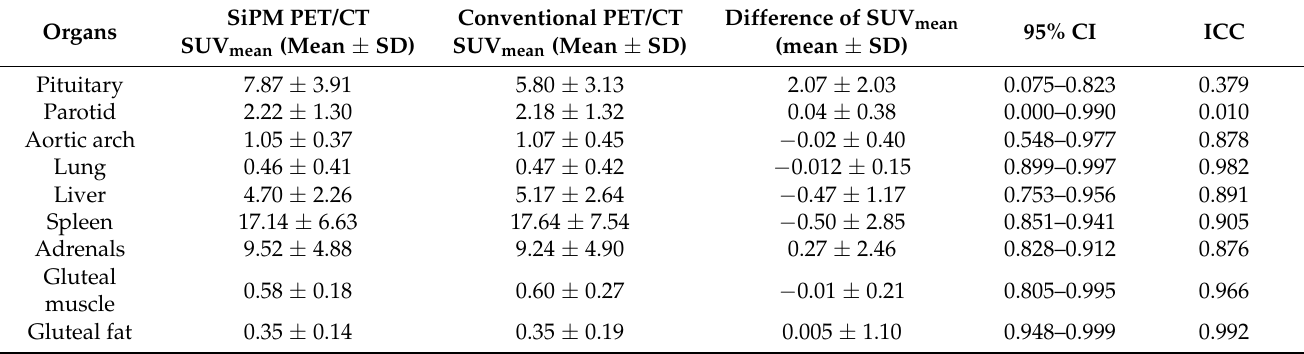
Table 1. SUV mean measurements in background